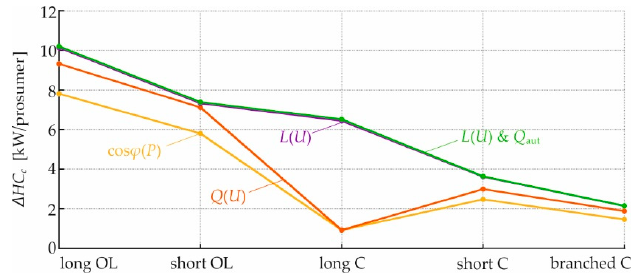
Figure 18. HC increase of each Volt/var control strategy for each LV test-feeder.